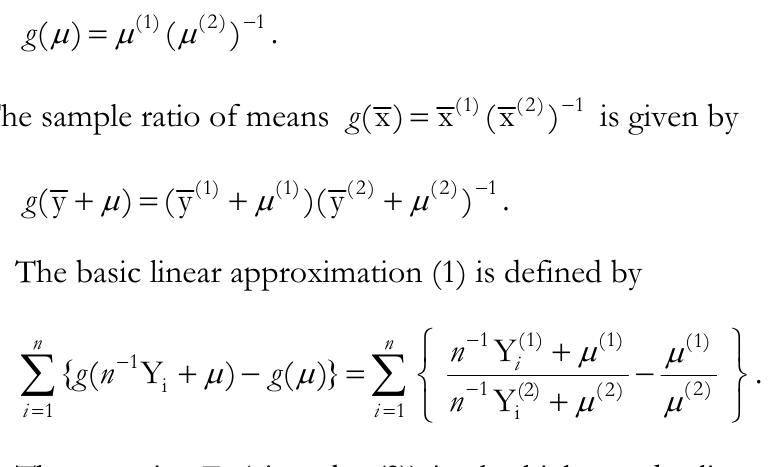
The quantity (cid:42) (given by (2)) in the higher-order linear approximation (3)